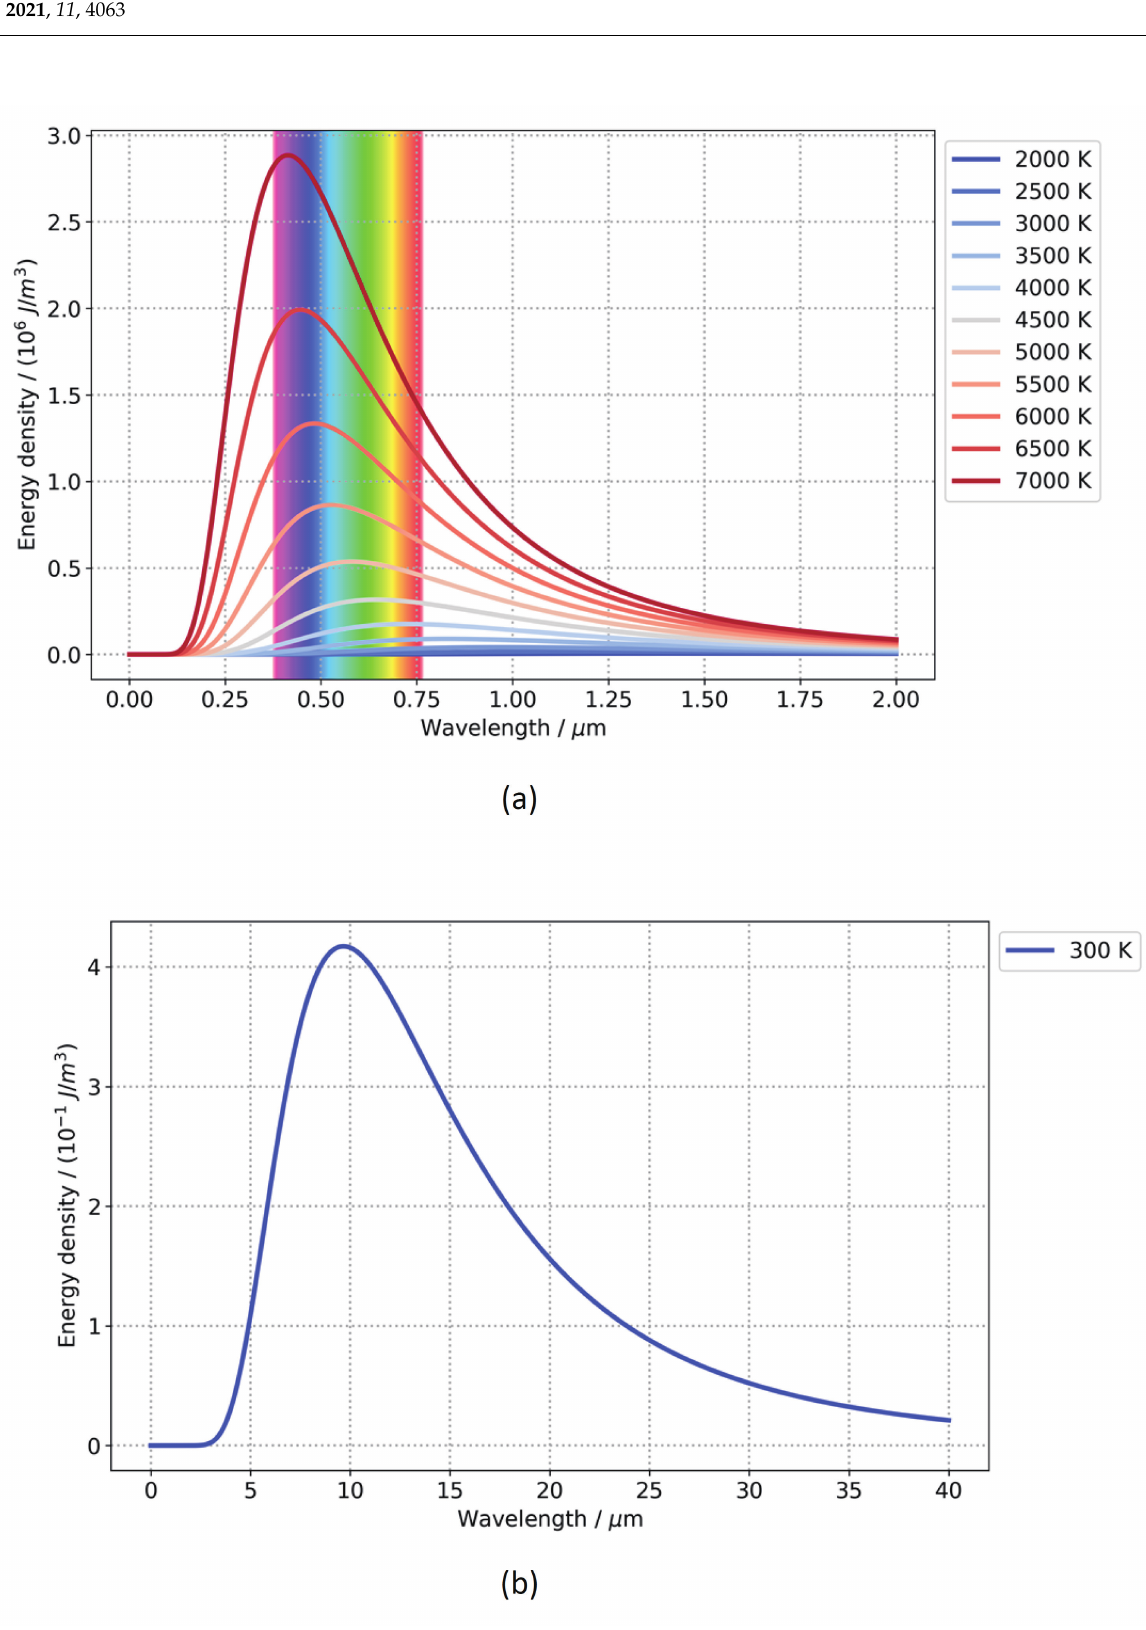
Figure 2. Planck’s curve: ( a ) from 2000 K to 7000 K, ( b ) at room